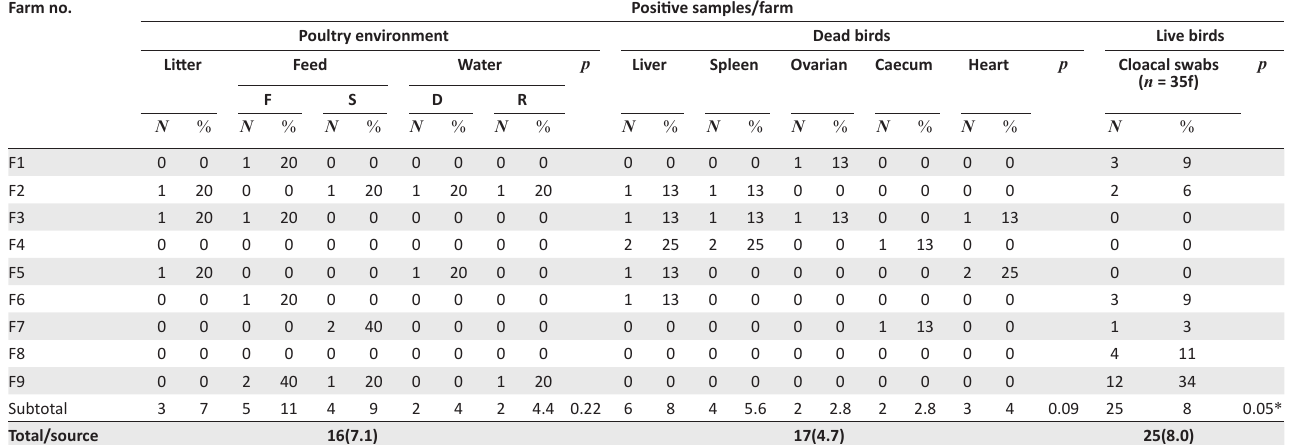
TABLE 3: Isolation rate of Salmonellae from different sample types. Farm no.